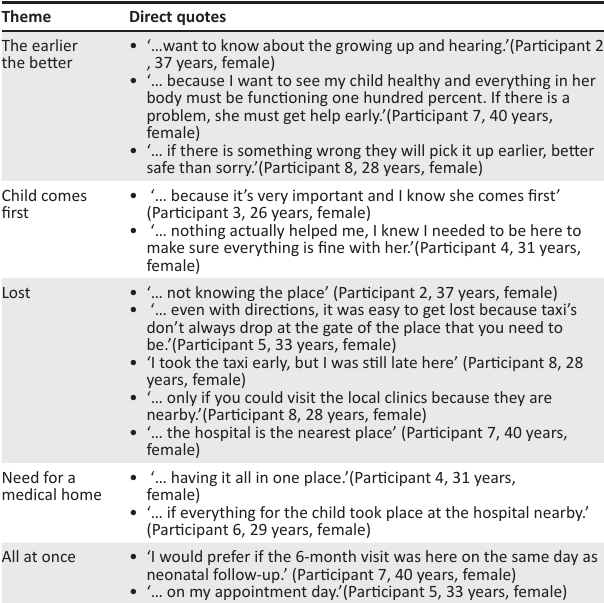
TABLE 1: Summary of themes from qualitative